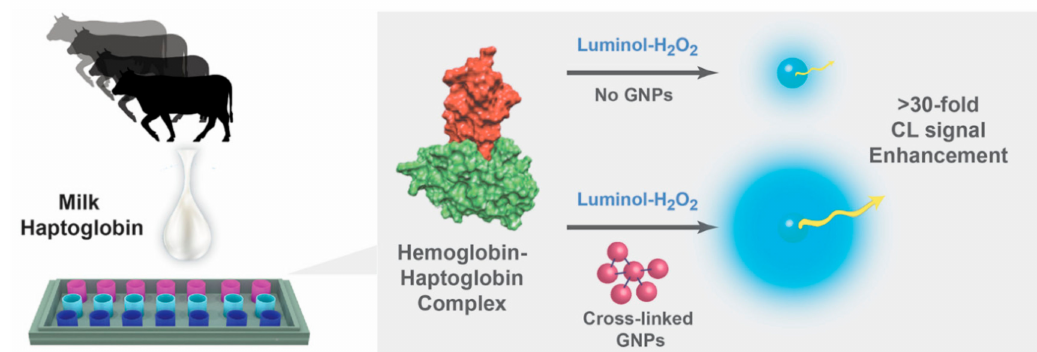
Figure 1. A schematic illustration of the haptoglobin sensing concept using cross-linked gold nanoparticles (GNPs) for enhanced chemiluminescence (eCL). The hemoglobin-modified plate specifically reacts with inherent haptoglobin content in milk. The subsequent protein–protein (hemoglobin–haptoglobin) complex hinders the catalytic activity of hemoglobin in proportion to inherent haptoglobin concentration. Reduced quantity of target molecules can be amplified by the addition of cross-linked GNPs onto the luminol mixture to intensify the emitted radiation for highly sensitive detection of the acute phase